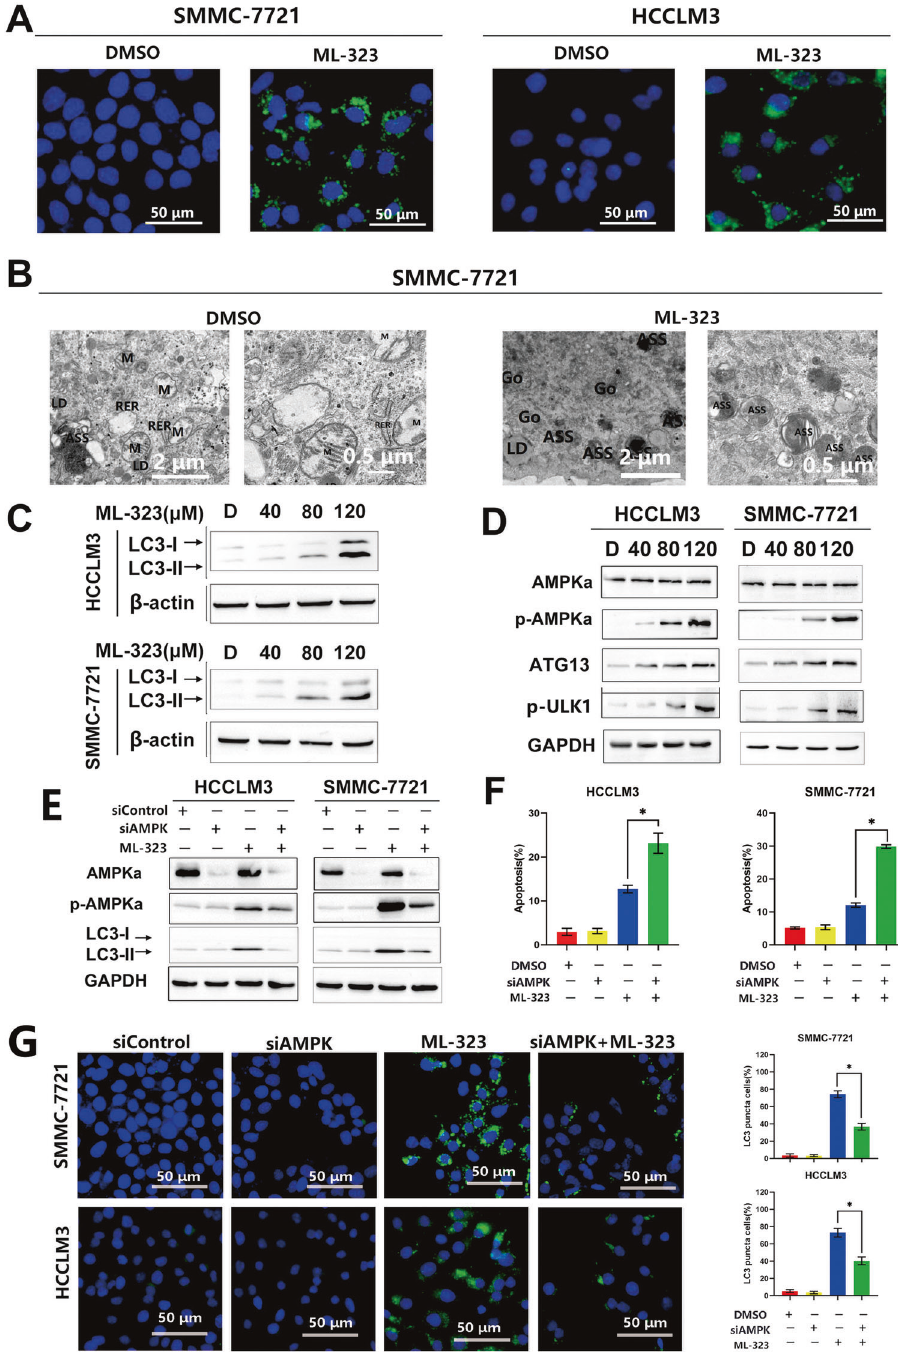
Fig. 4 The AMPK-ATG13/ULK1 axis plays a role in ML-323-induced autophagy. A Immuno fl uorescence staining of the autophagic marker LC3B. HCCLM3 and SMMC-7721 cells were treated with ML-323 for 24 h and then incubated with LC3B primary antibody (1:200, 4 °C overnight) and Alexa Fluor 488 goat anti-rabbit IgG (H + L) secondary antibody (green) (1:500, 2 h at 25 °C), respectively. DAPI staining (blue) (5 μ g/mL, 25 °C, 20 min). Images were captured using a fl uorescence microscope. Representative images are shown. B Electron microscopic images showing the accumulation of autophagosomes in ML-323-treated HCC cells. ASS represent autophagosomes. (M: Mitochondrion, RER: Rough endoplasmic reticulum, Go: Golgi apparatus, LD: Lipid droplets). C Western blot analysis of LC3B expression levels in HCCLM3 and SMMC-7721 cells. D Western blot analysis of proteins related to the AMPK-ULK1-ATG13 signaling pathway in ML-323-treated HCCLM3 and SMMC-7721 cells. ML-323 activates the AMPK-ULK1-ATG13 signaling pathway. E Western blot analysis showing the effect of co-treatment with siRNA control, siAMPK, and ML-323 on protein expression. The HCCLM3 and SMMC-7721 cells were treated with ML-323 alone or in combination with siRNA control or siAMPK. F Annexin V-FITC /PI double-staining of AMPK-de fi cient HCC cells. After transfection with siControl or siAMPK, HCCLM3 and SMMC-7721 cells were treated with ML-323 for 48 h. G LC3B immuno fl uorescent staining of AMPL-de fi cient HCC cells shows that blocking AMPK reduced ML-323-induced autophagy. HCCLM3 and SMMC-7721 cells were treated with ML-323 alone or in combination with siRNA or siAMPK. Data represent at least three independent experiments ( n = 3; error bars, SD).